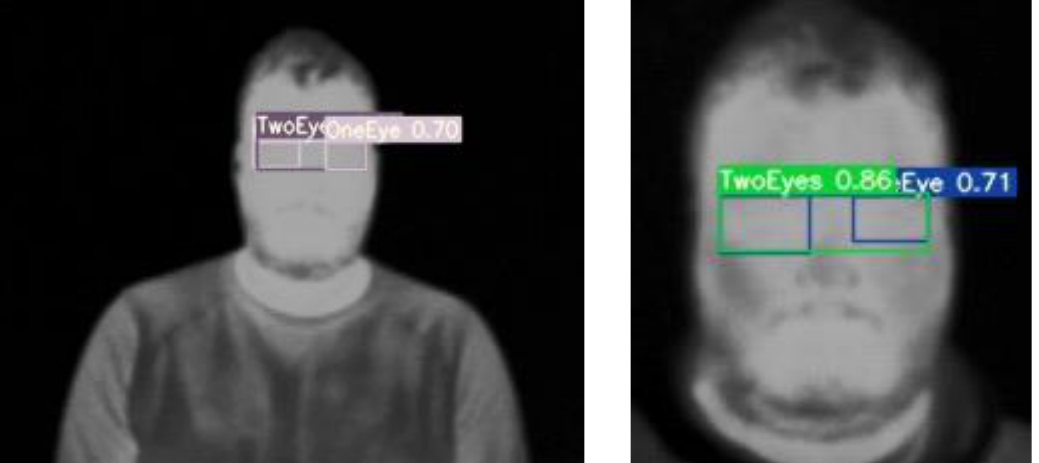
Figure 15. Distance effect on eyes detection by YOLOv7 model trained on the augmented multi-age dataset.